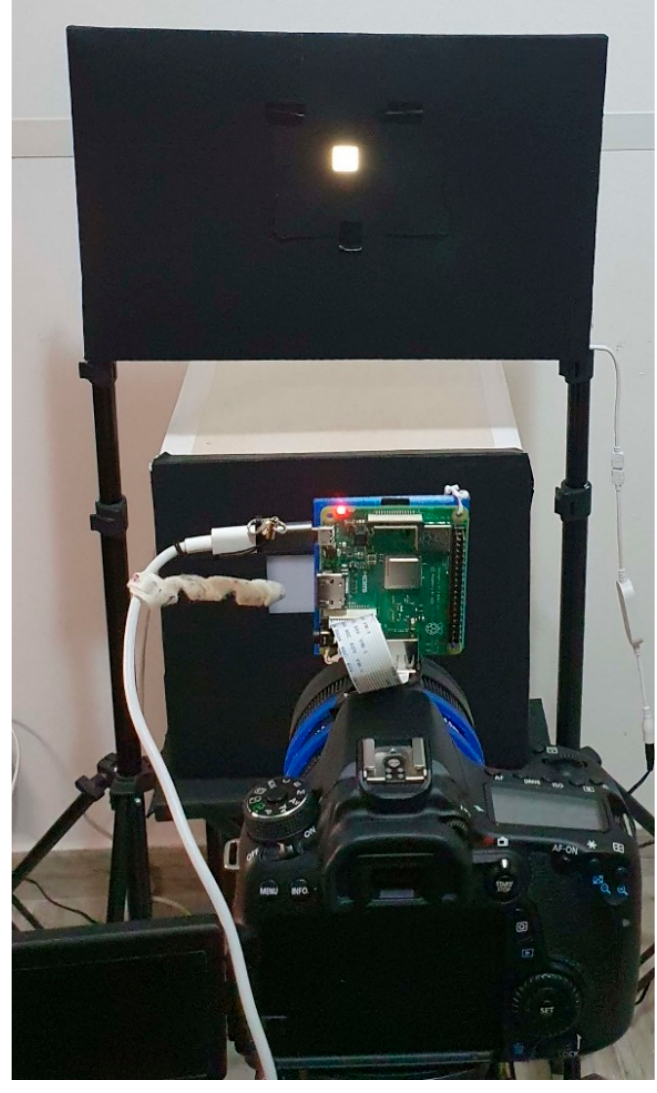
Figure 6. Setup for vignetting assessment: LED panel set as neutral white with 100% of intensity. Illuminated area = 2 × 2 cm 2 . Low-cost camera positioned at 60 cm from the LED panel. The low-cost camera is rotated by 11.25 ◦ each time, covering the FOV of the lens, and three images at different exposure are acquired each